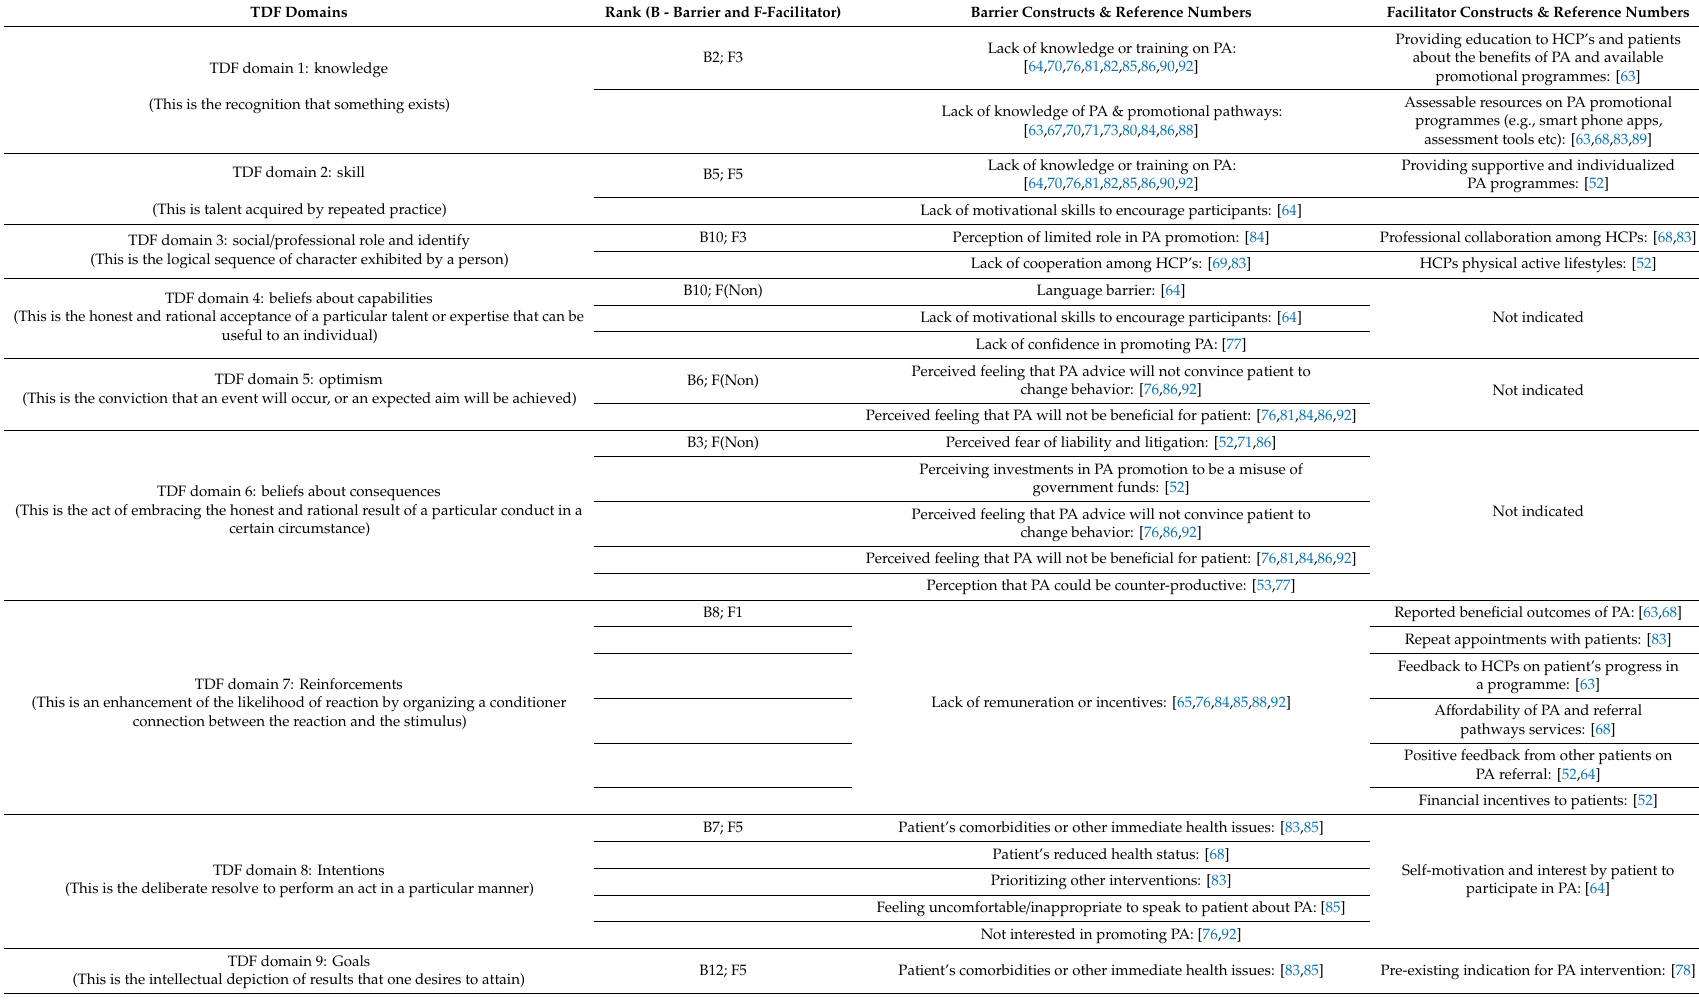
Table 3. Participants’ perceived barriers and facilitators to PA